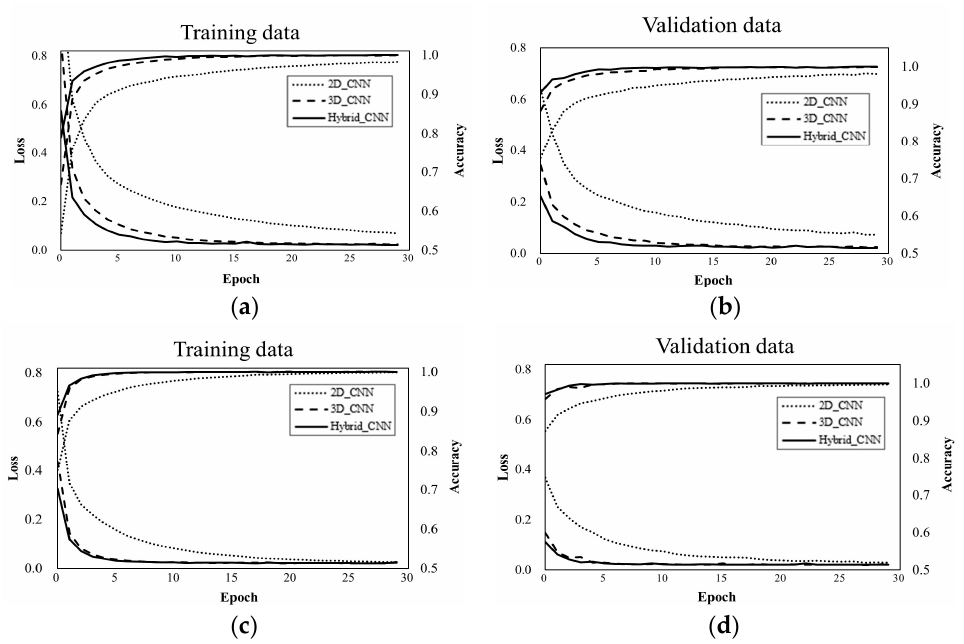
Figure 7. Classification losses and accuracies in each epoch on ( a ) training samples, ( b ) validation samples at Site 1, ( c ) training samples, ( d ) validation samples at Site 2.